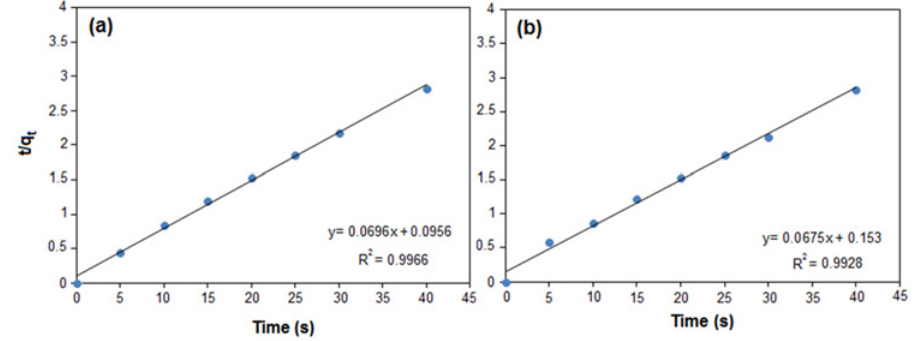
Fig 7. Pseudo- second- order kinetics for (a) Cu(II) and (b) Pb(II).